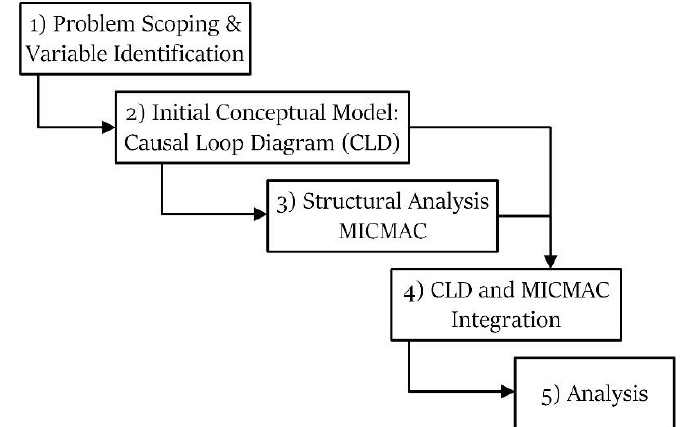
Figure 1. A multi-method systems approach development framework.